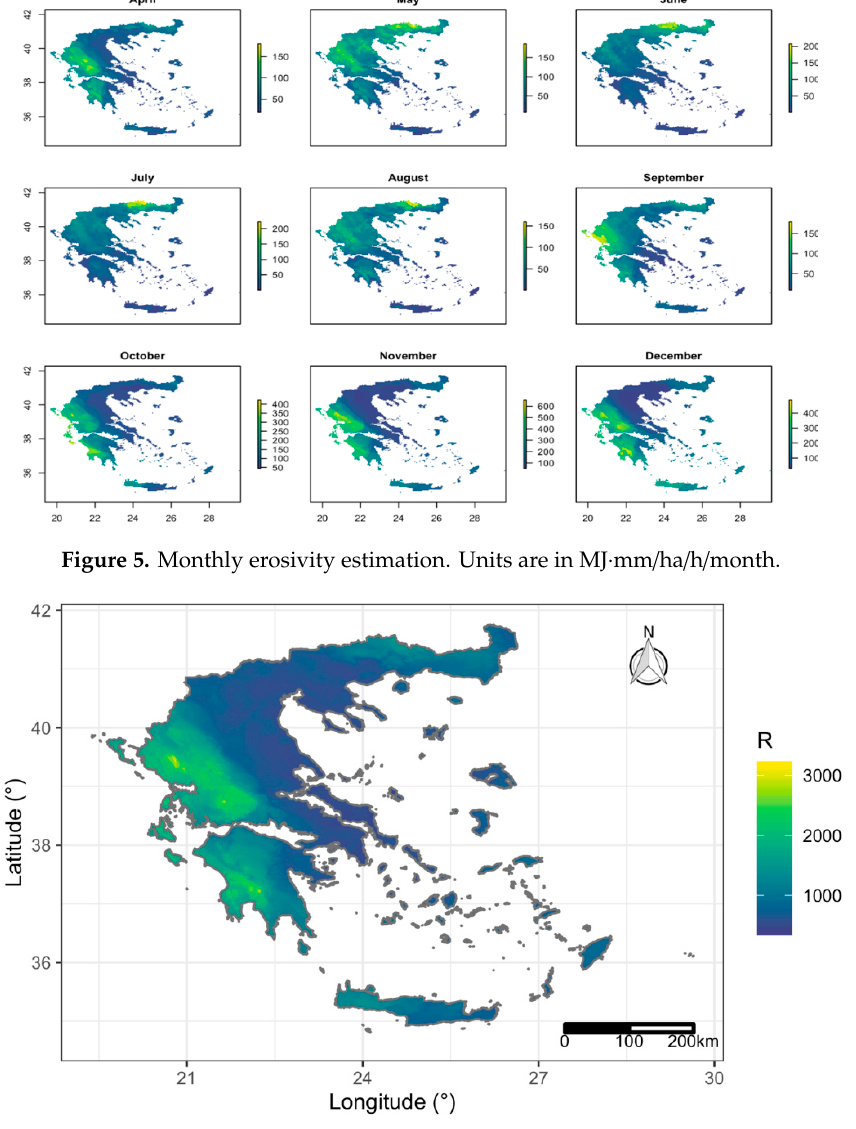
Figure 6. Annual rainfall erosivity. Values are in MJ·mm/ha/h/y. Available online in Supplementary materials.